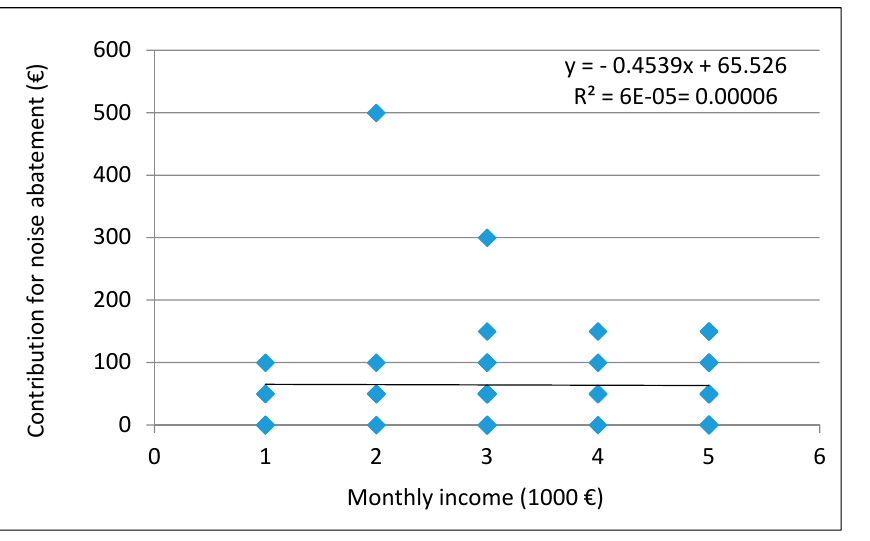
Figure 3. Dependence of declared contributions for noise abatement on monthly incomes.